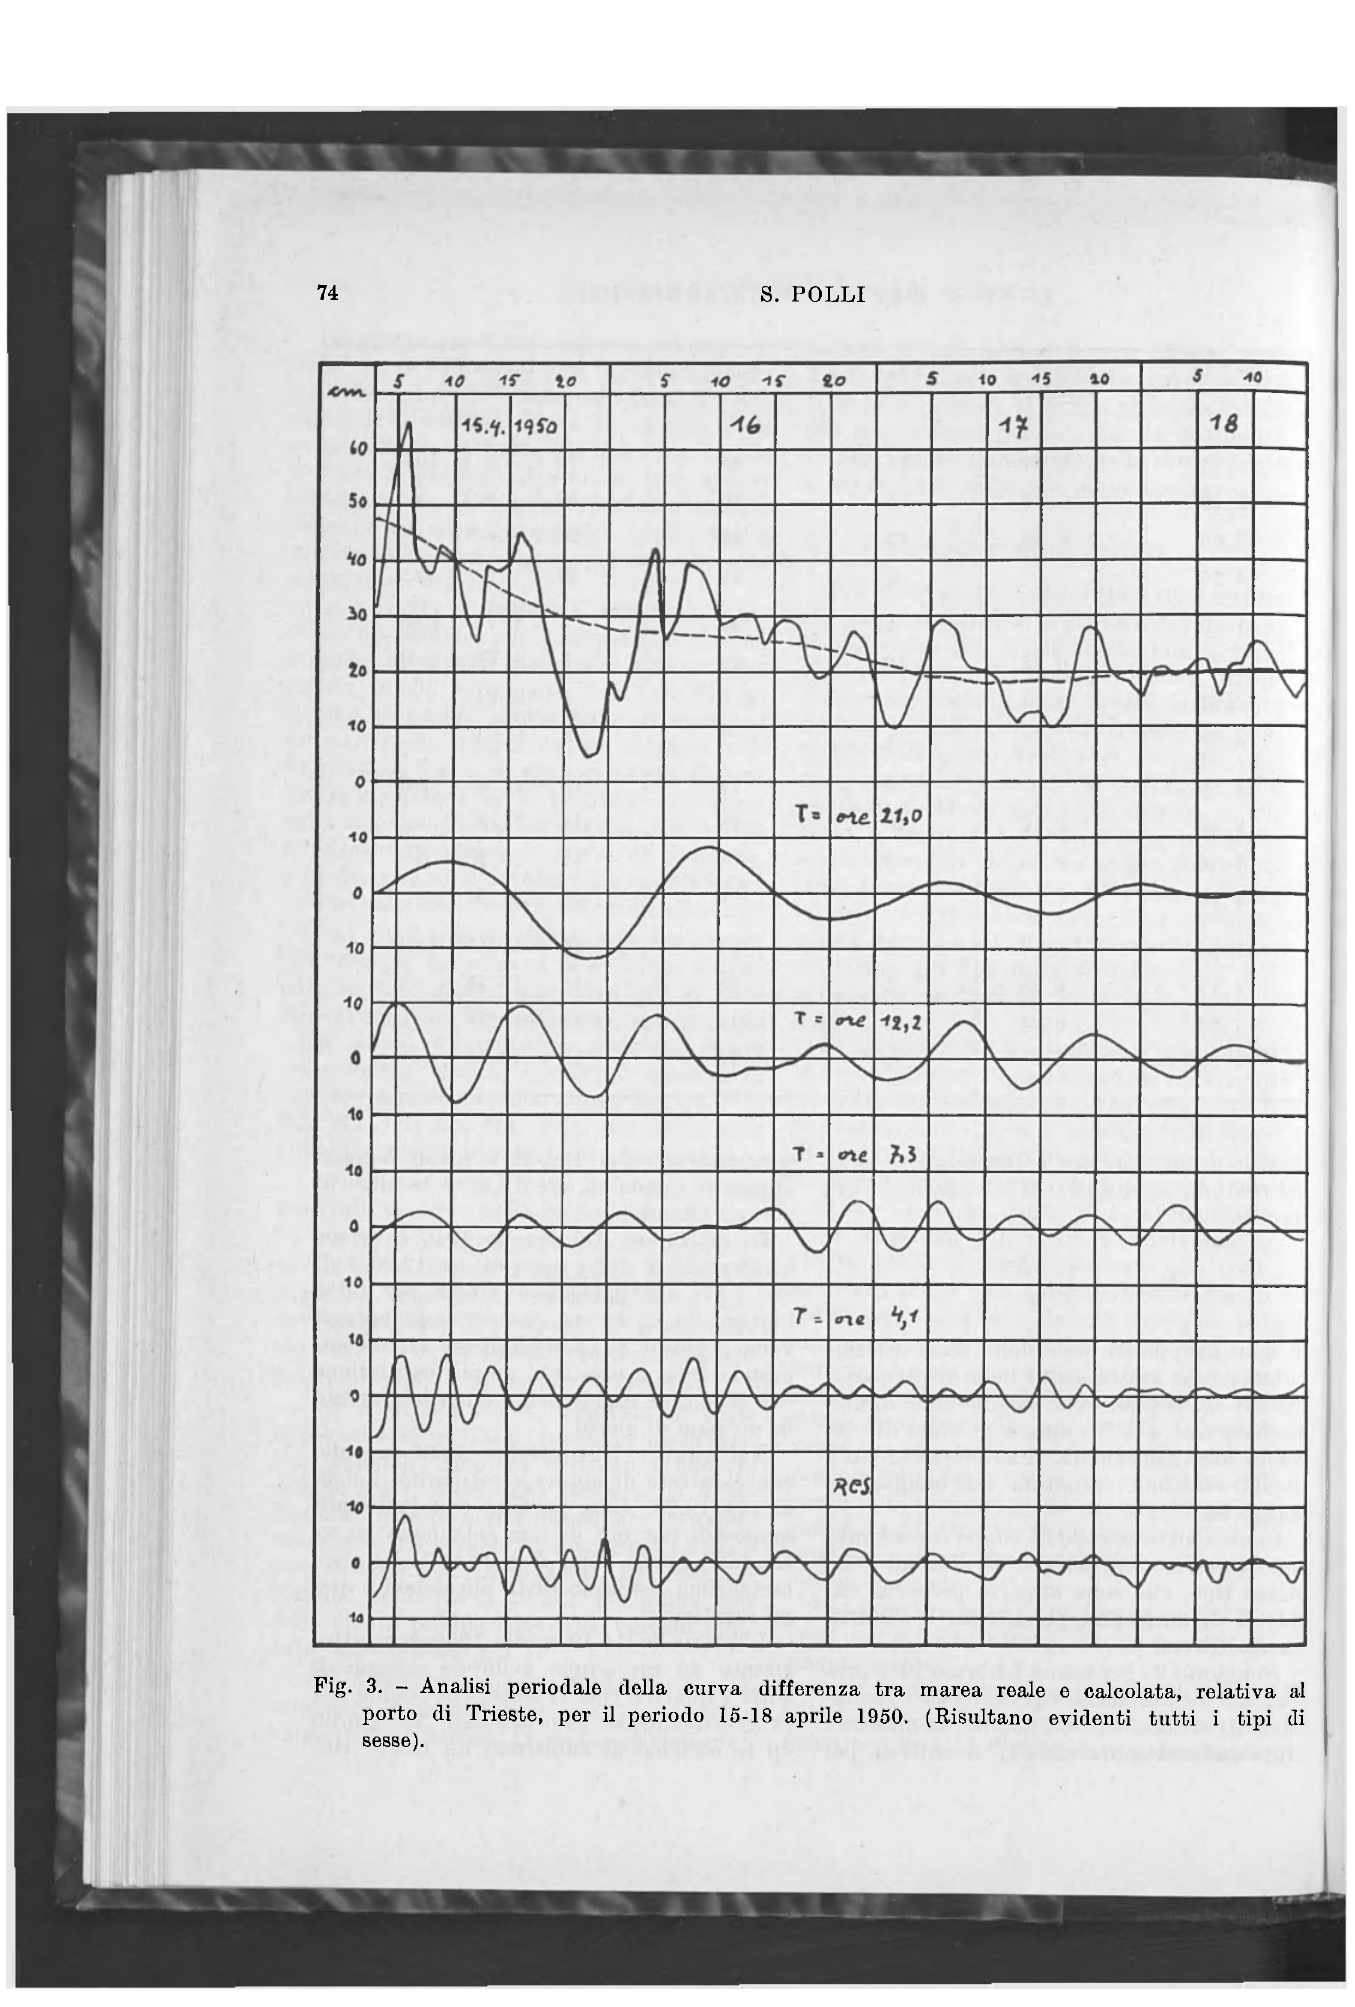
Fig. 3. - Analisi periodale della curva differenza tra marea reale e calcolata, relativa al porto di Trieste, per il periodo 15-18 aprile 1950. (Risultano evidenti tutti i tipi di